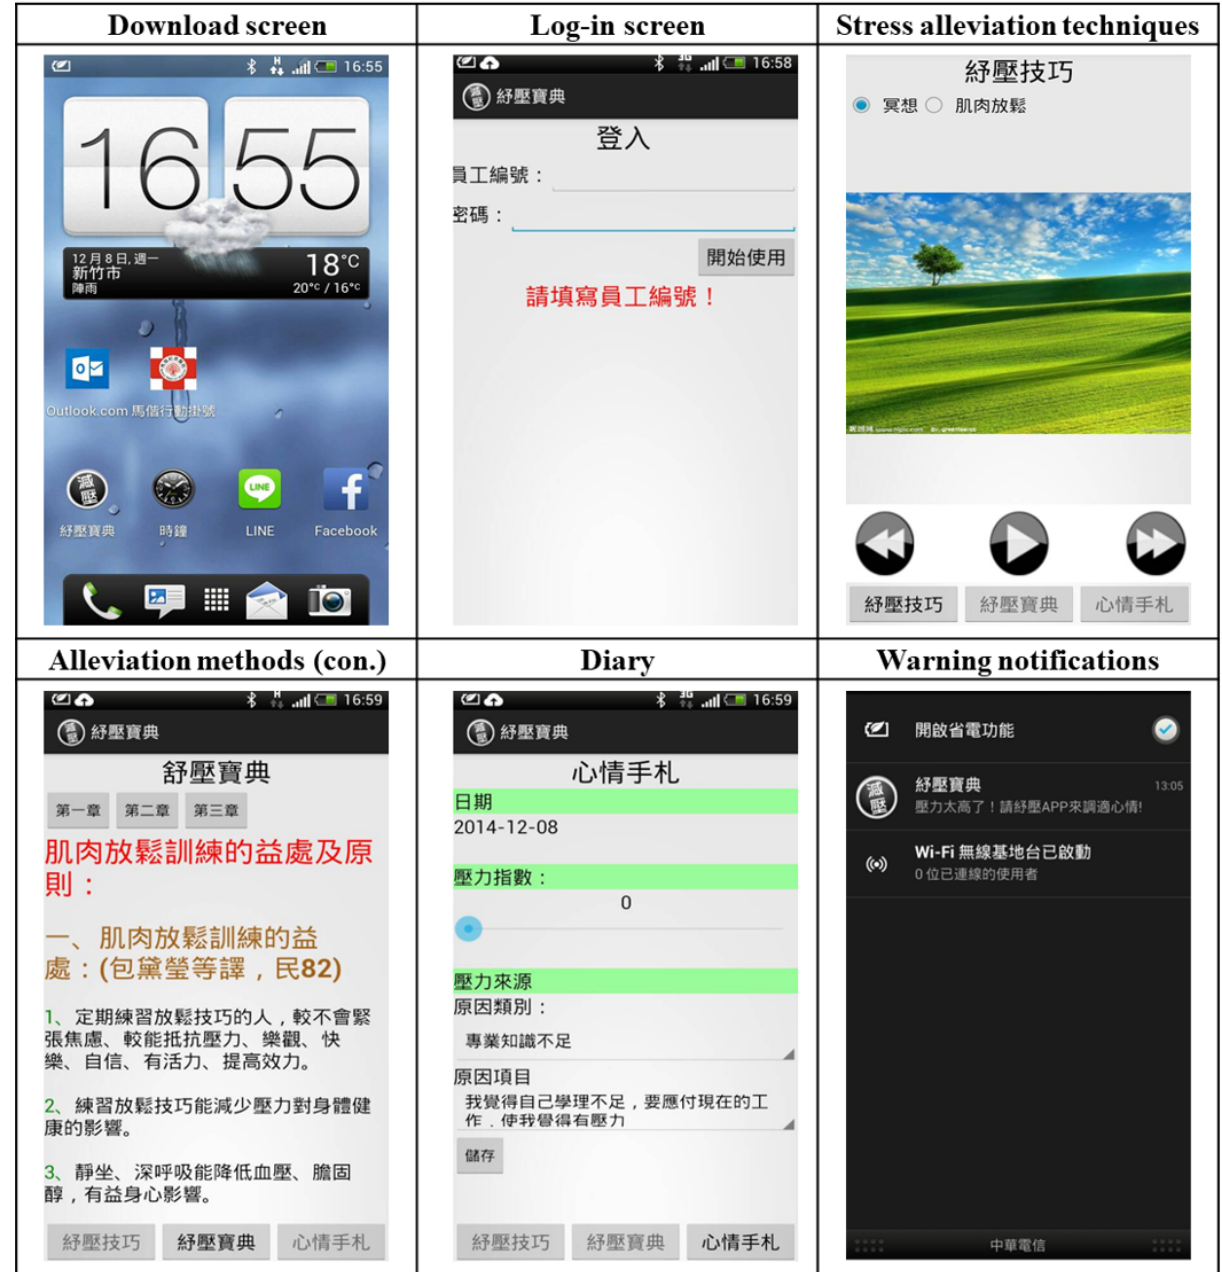
Figure 1. SR-App